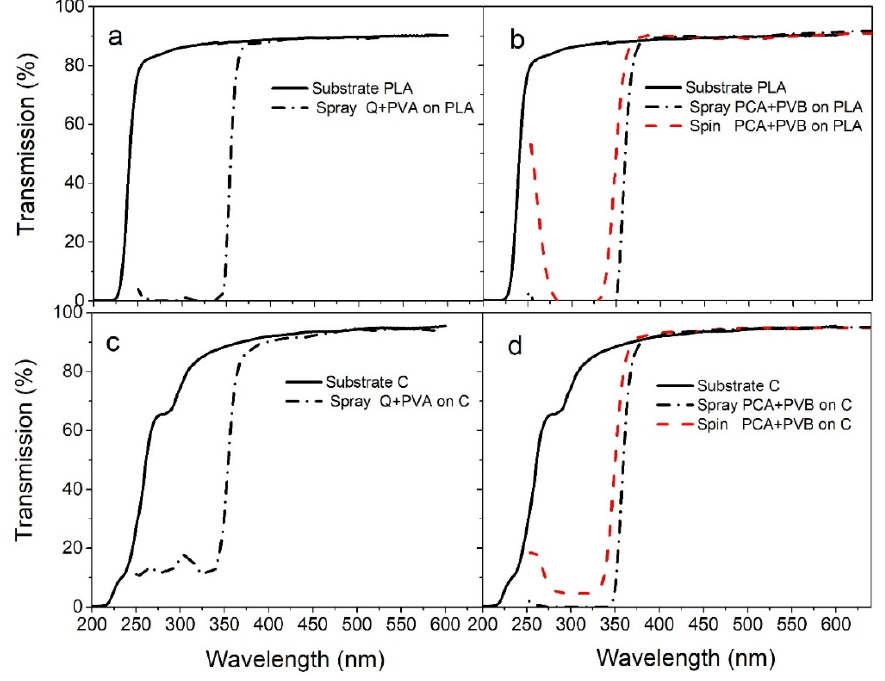
Figure 4. ( a ) Transmission spectra of the PLA substrate (black solid line) and of the spray-coated film of the blend PVA-Quinine on PLA substrate (black dash line); ( b ) Transmission spectra of the PLA substrate (black solid line) and of the spray-coated film (black dash line) and the spin-coated film (red dash line) of the blend PVB-P Coumaric acid on PLA substrate; ( c ) Transmission spectra of the cellulose substrate (black solid line) and of the spray-coated film of the blend PVA-Quinine on the cellulose substrate ( d ) Transmission spectra of the cellulose substrate (black solid line) and of the spray-coated film (black dash line) and the spin-coated film (red dashed line) of the blend PVB-P Coumaric acid on cellulose substrate.